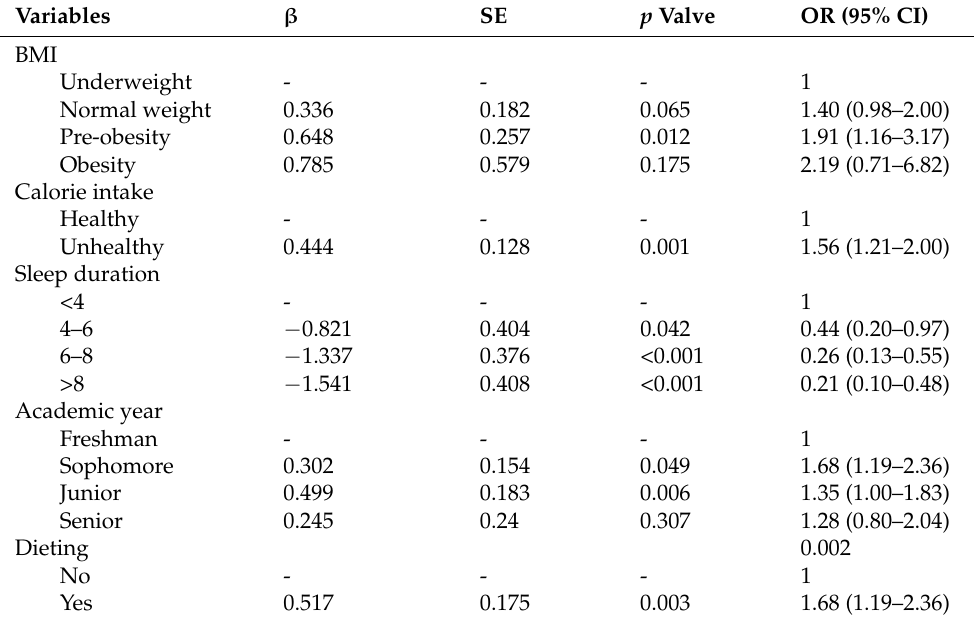
Table 5. Results of multivariate logistic regression analysis of